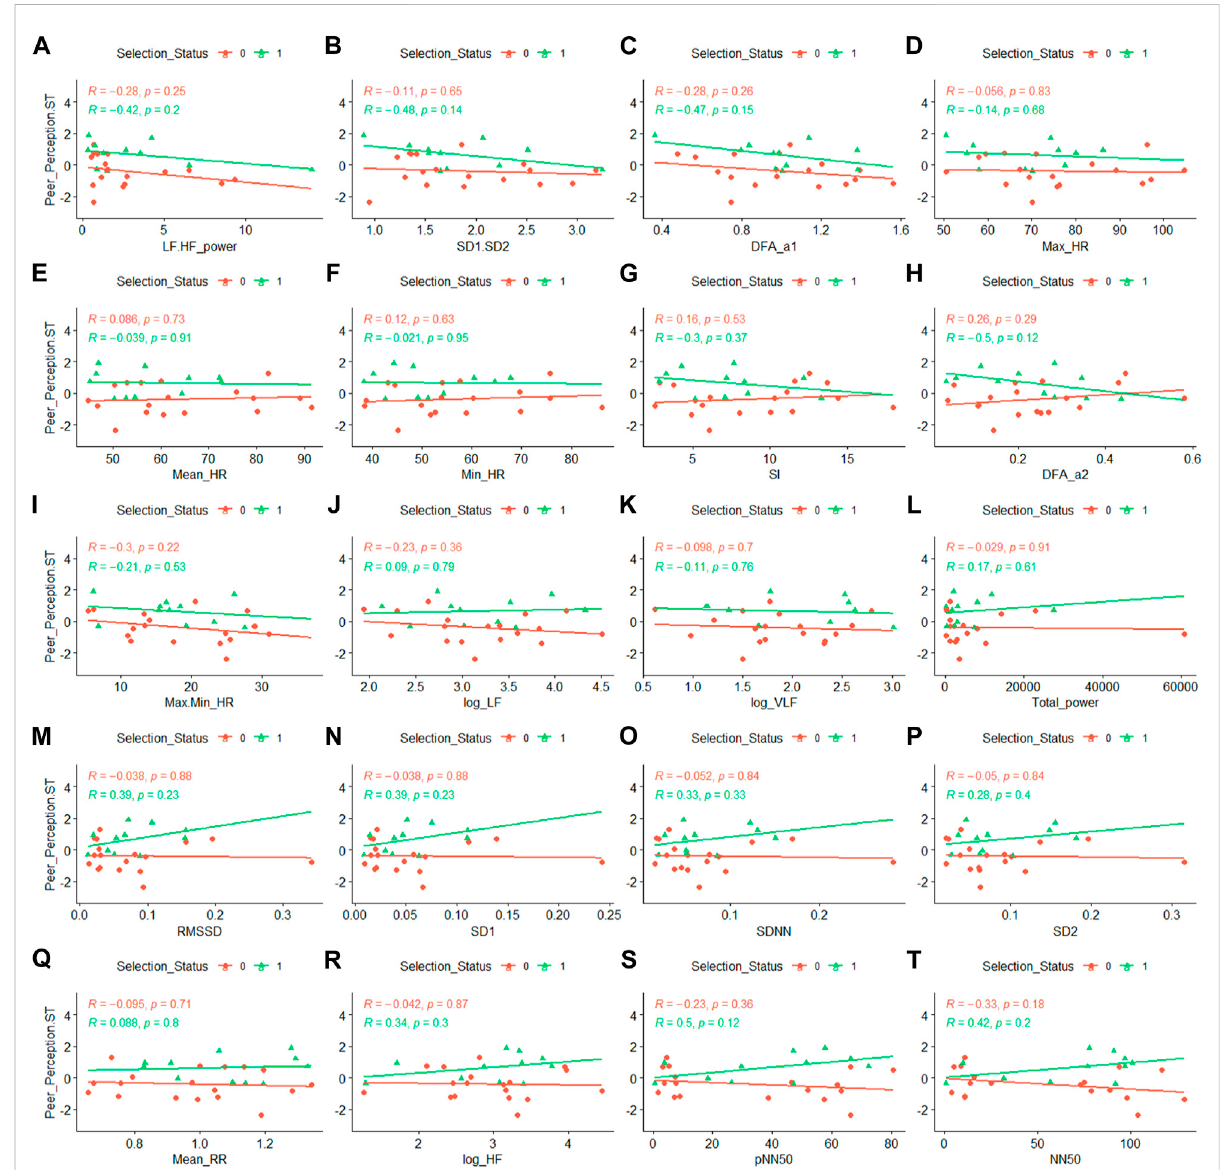
Correlation between Peer Perception-ST and HRV metrics by Selection Status. Selection Status of 0, shown in red with circular data points, indicates a non-selected participant, and Selection Status of 1, shown in green with triangular data points, indicates a selected participant. Abbreviations: ST, stress tolerance; HRV, Heart Rate Variability. Panel descriptions (A) LF.HF, Ratio of low frequency (LF) to high frequency (HF) band powers; (B) SD1.SD2, Ratio of Poincaré Perpendicular Standard Deviation (SD1) to Poincaré Parallel Standard Deviation (SD2); (C) DFA α 1, short- term detrended fl uctuation analysis; (D) Max Heart Rate; (E) Mean Heart Rate; (F) Minimum Heart Rate; (G) SI, Stress Index; (H) DFA α 2, long-term detrended fl uctuation analysis; (I) Max.Min HR,Heart Rate Range; (J) logLF, naturallog ofLF; (K) logVLF,natural log ofVery-LowFrequency; (L) Total Power; (M) RMSSD, Root Mean Square of Successive Differences; (N) SD1; (O) SDNN, Standard Deviation between R-R intervals; (P) SD2; (Q) Mean RR,R toR interval inECGrhythm; (R) logHF, natural log ofHF; (S) pNN50, percentageofsuccessive R-R intervals that deviate greater than 50 ms; (T) NN50, number of R-R intervals that deviate greater than 50